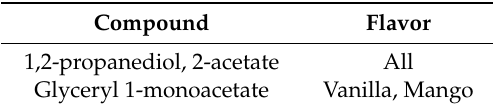
Table 6. Compounds observed in e-liquid and